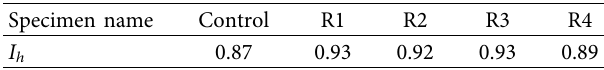
Table 6: Average I h of the three aging levels of each specimen type.